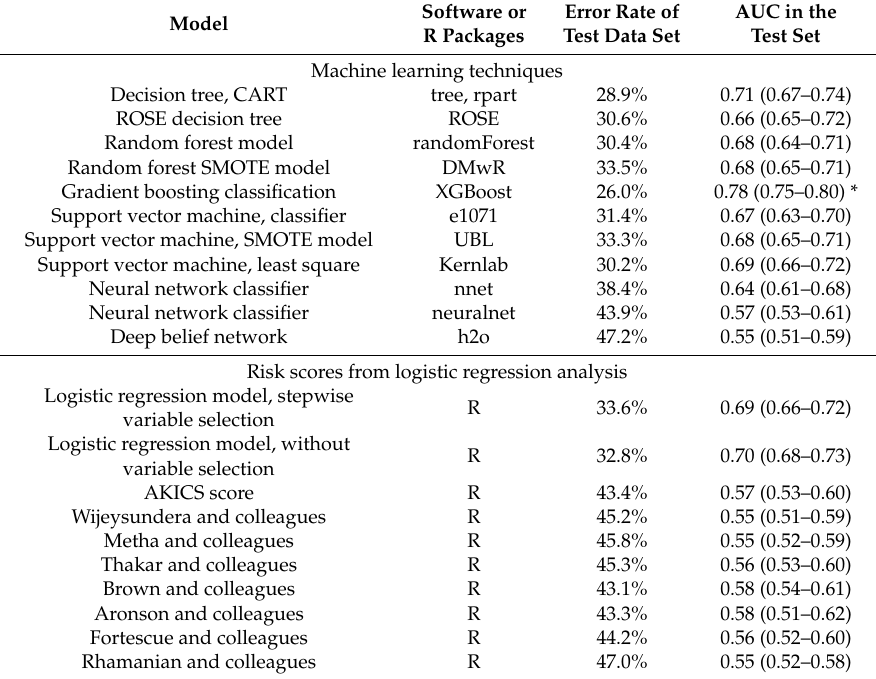
Table 2. Comparison of area under receiver-operating characteristic curve among the different models.